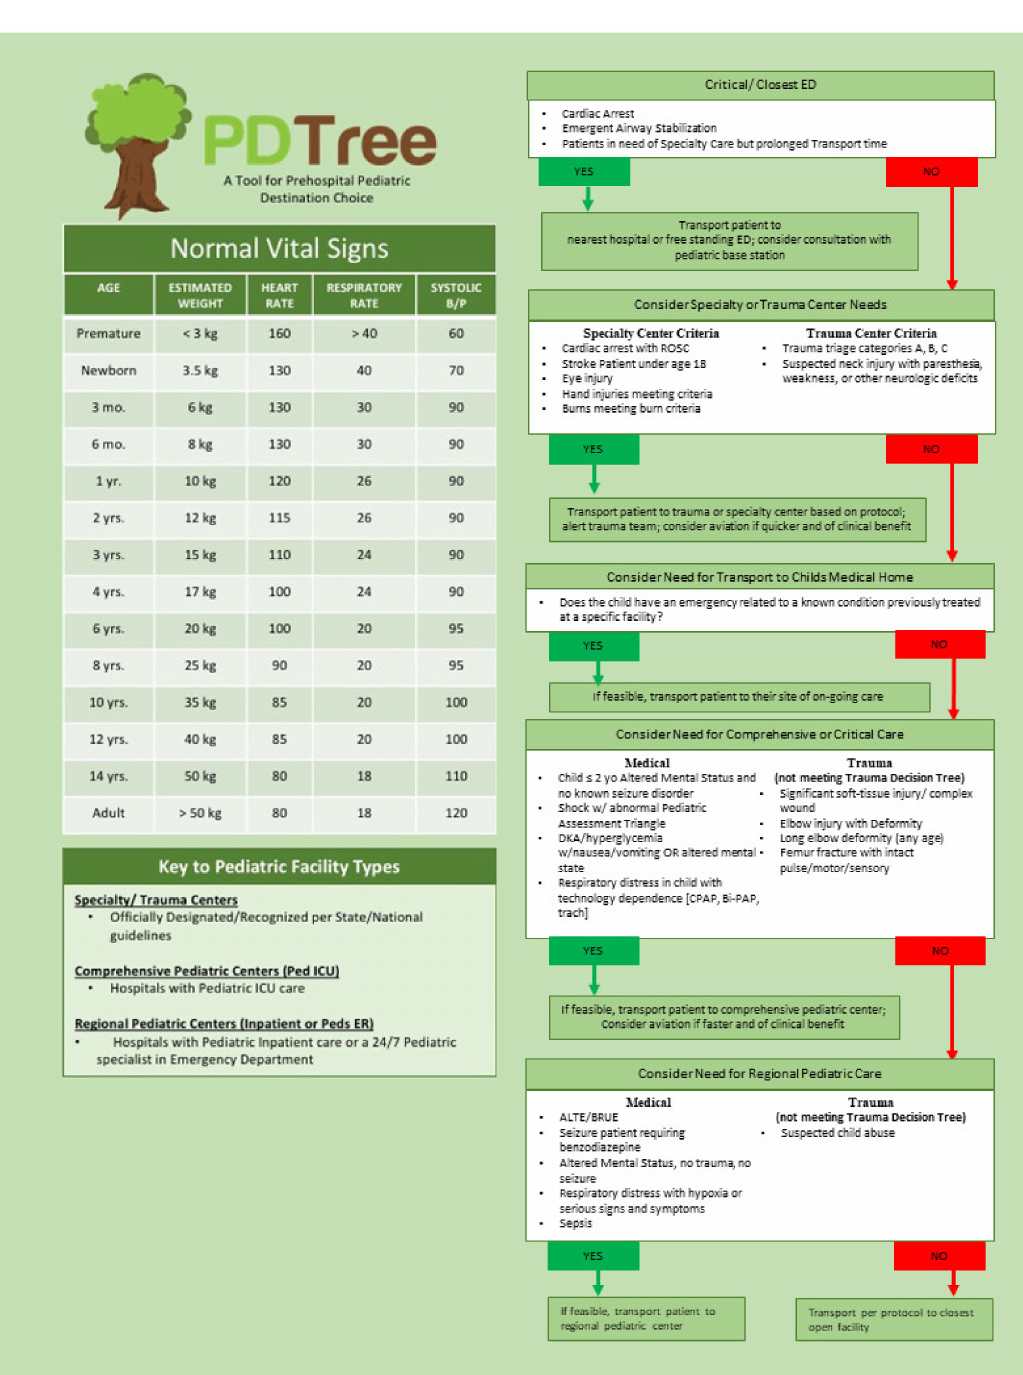
Figure 1. The Pediatric Decision Tree (PDTree) destination-decision support tool. Detailed criteria for Triage Categories and the Maryland Trauma Decision Tree referenced in the tool is found in [25] and are consistent with existing CDC trauma triage guidance [17]. Burn center criteria refer to the recommendations of the American Burn Association and can be found in